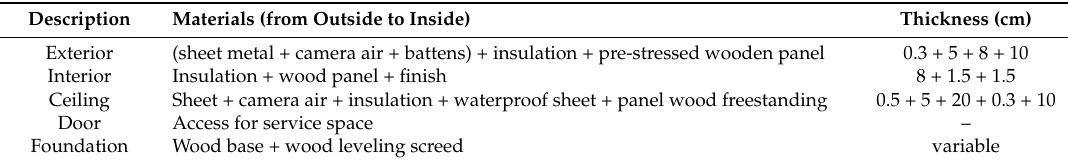
Table 3. The enclosure materials used in the actual prototype.